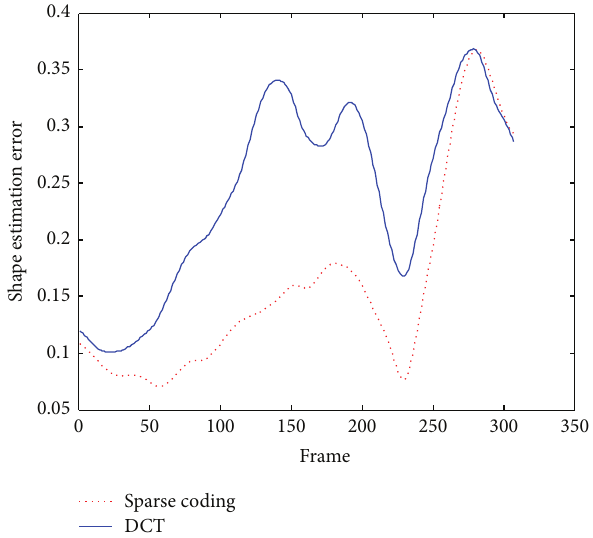
Figure 3: Estimation errors of each frame on the “Yoga” sequence. The top line denotes the results curve with DCT method when the size of DCT bases is 12, and another line denotes the results curve with sparse coding method (better viewed in color).